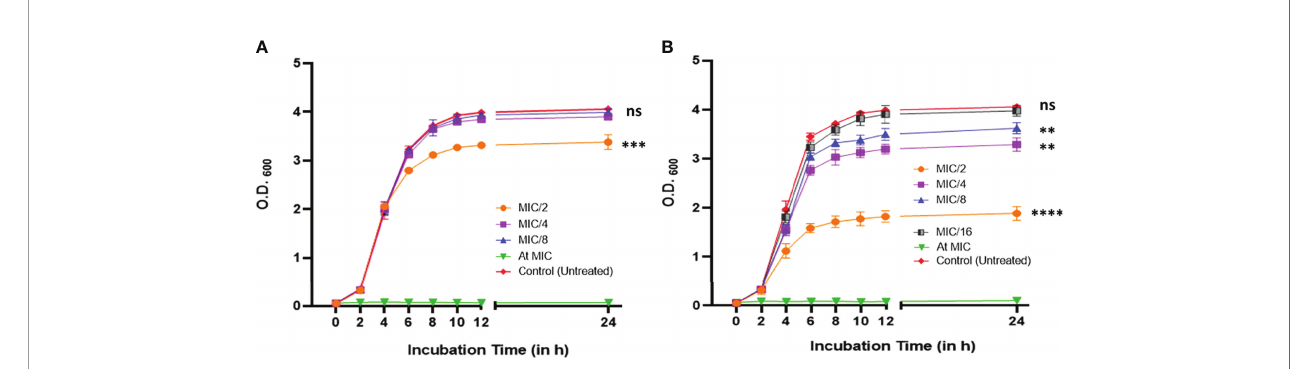
FIGURE 1 | Growth pro fi le of P. aeruginosa PAO1 at 600 nm in the absence and presence of different sub-minimum inhibitory concentrations of (A) CiNN and (B) GeN. (ns, not signi fi cant, **p ≤ 0.01, ***p ≤ 0.001, ****p ≤ 0.0001).